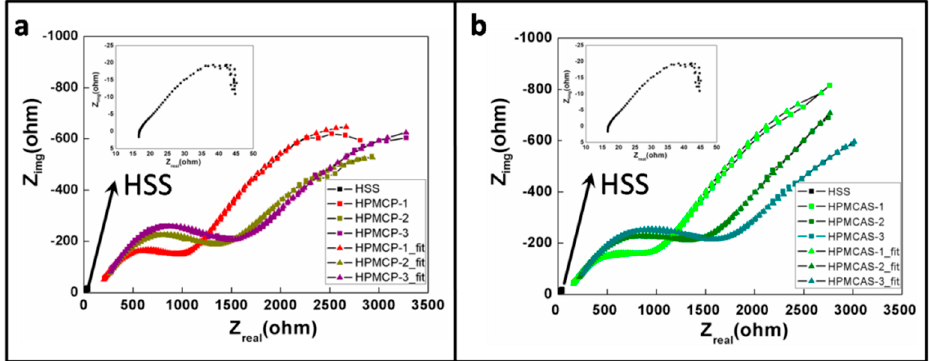
Figure 3. Nyquist plot of ( a ) HPMCP with varying thickness, where the inset is the Nyquist plot of uncoated high speed steel (HSS); ( b ) HPMCAS with varying thickness.